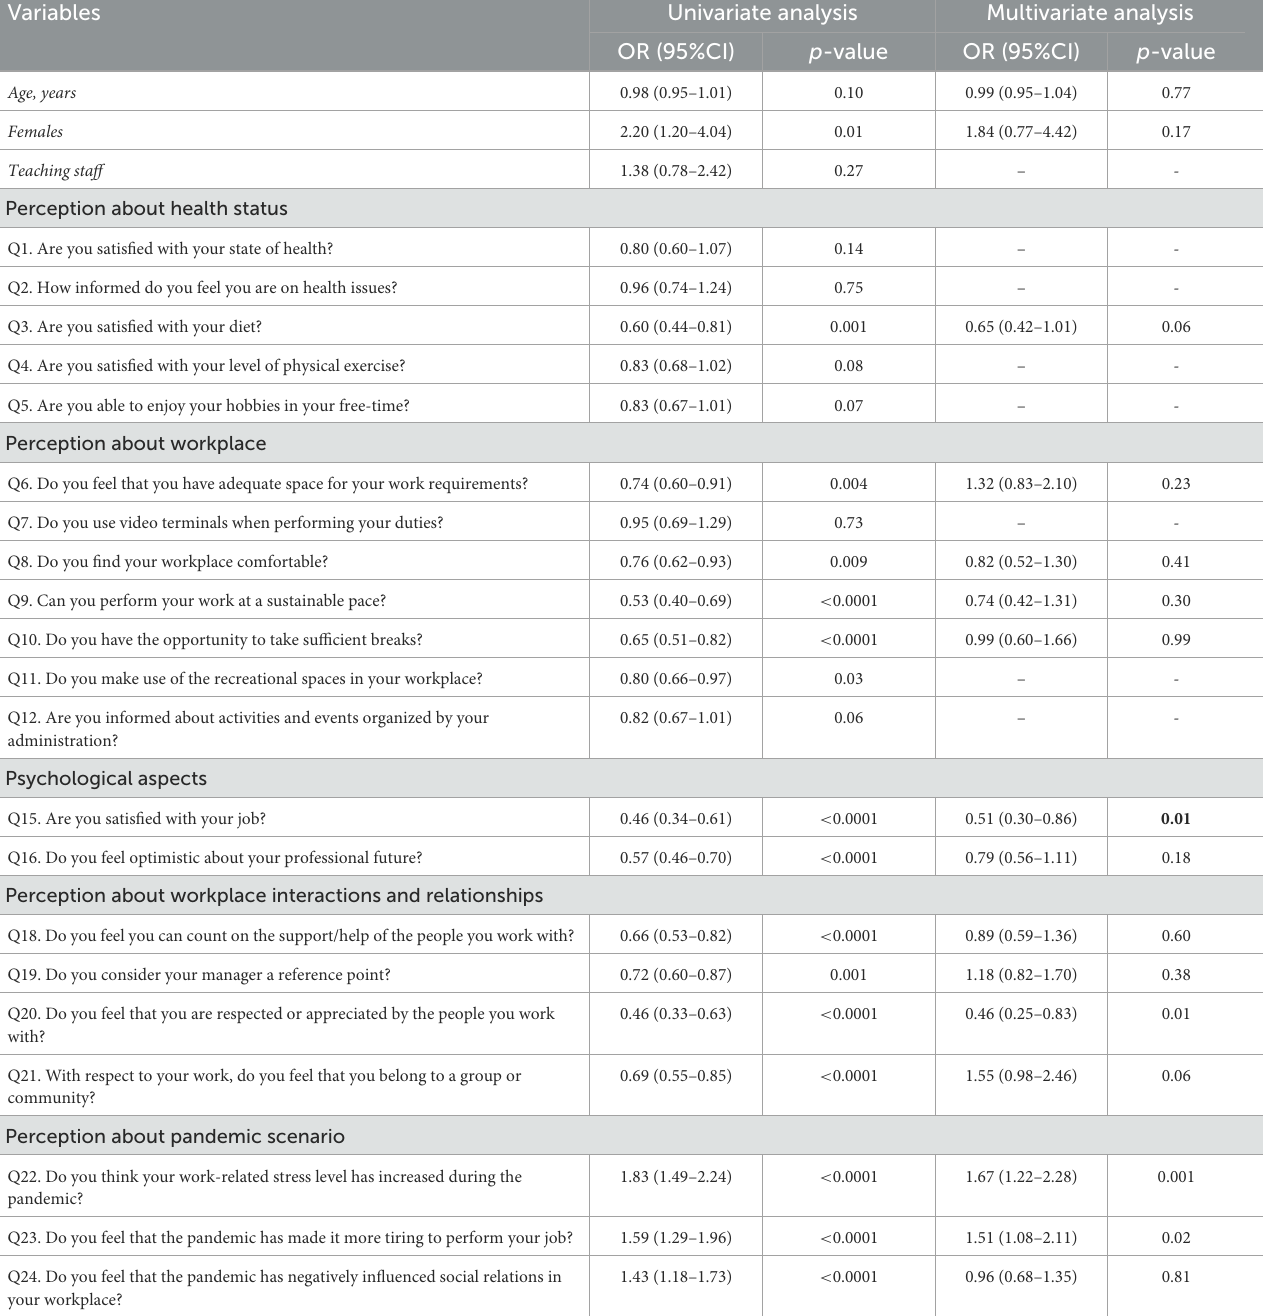
TABLE 3 Logistic regression to assess relationship between socio-demographic characteristic and perception of working environment, and work-related anxiety/panic.